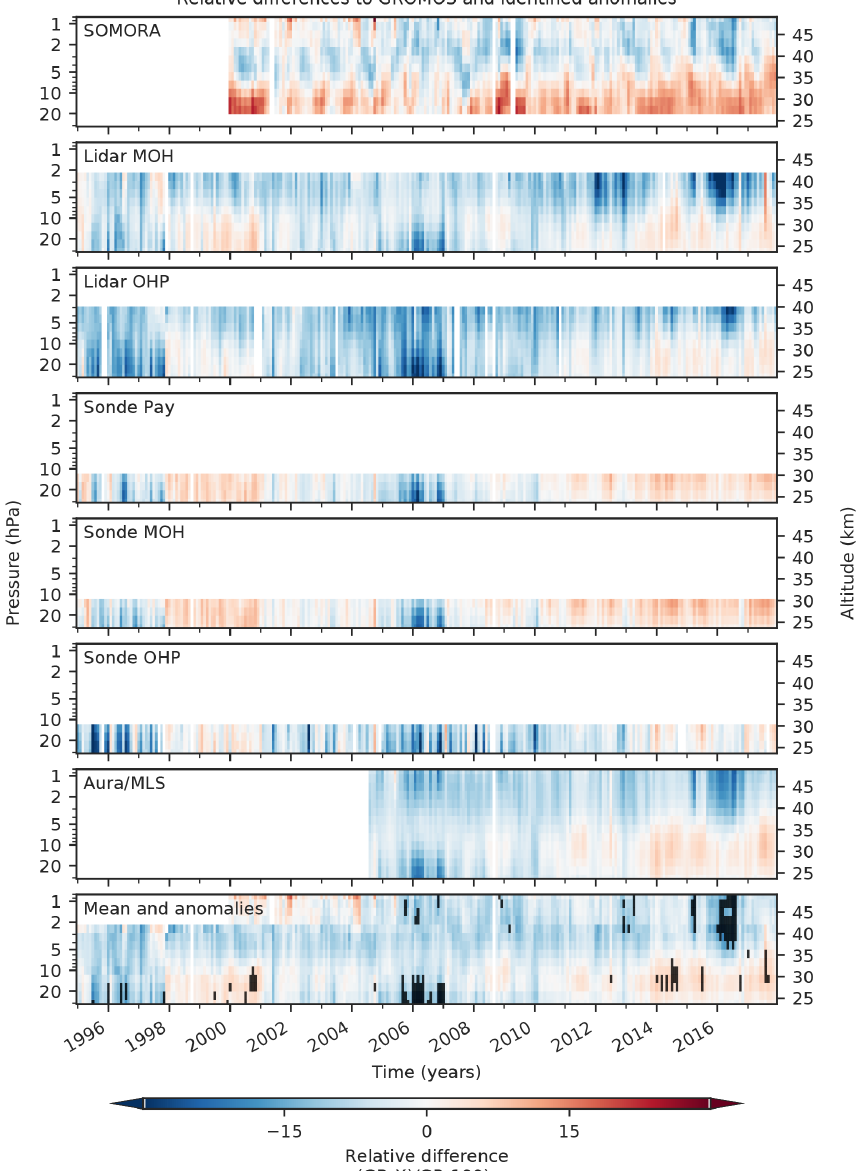
Figure 4. Relative differences (RDs) of monthly means between GROMOS and SOMORA, lidars (MOH and OHP), ozonesondes (Payerne, MOH, OHP), and Aura/MLS. The lowest panel shows the mean of all RDs. The black areas in the lowest panel show periods in which at least three data sets (or two data sets above 2hPa) have a debiased relative difference (RD debiased ) larger than